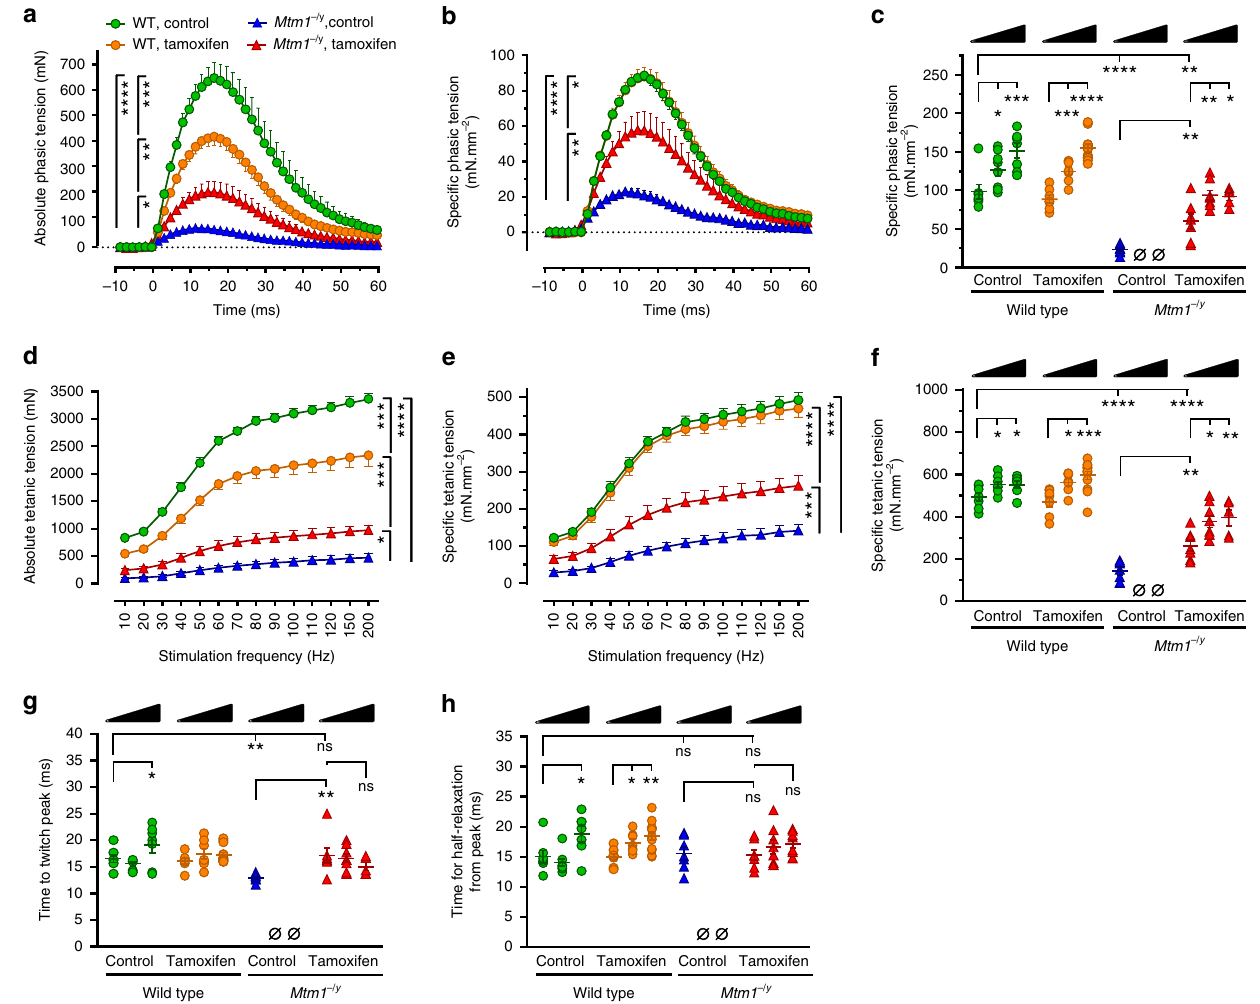
Fig. 2 Tamoxifen augments the strength of leg muscles of XLMTM mice. Electrically evoked triceps contractions were recorded under isometric conditions and contractile features analyzed in 42, 84, and 210-day-old mice fed placebo or tamoxifen-supplemented (30 mg kg − 1 ) diets. a Average traces showing absolute phasic (twitch) contraction of the triceps at 42 days (D42). Tamoxifen signi fi cantly enhanced the force (tension) in Mtm1 − /y mice. b Speci fi c phasic force (see Online Methods for details) of D42 Mtm1 − /y mice augmented with tamoxifen. c Speci fi c phasic force of Mtm1 − /y mice increased with tamoxifen at all examined ages. d Average traces showing triceps absolute force-frequency curves at D42. Tamoxifen more than doubled the tetanic force of Mtm1 − /y mice. e Speci fi c force of Mtm1 − /y mice markedly augmented with tamoxifen at all stimulation frequencies. f Speci fi c tetanic force of Mtm1 − /y mice was considerably improved at all studied ages. In triceps examined after various treatment durations, tamoxifen rescued the impaired time to twitch peak of Mtm1 − /y mice ( g ) but had no impact on the time required for half-relaxation from peak ( h ). D42 panels: WT wild type; legend in a stands for a , b , d , e ; data represent the mean ± s.e.m. of n = 7 triceps per group. c , f , g , h : black triangles illustrate increasing age (42 – 84 and 210 days) within each treatment group; columns from left to right: data represent the mean ± s.e.m. of 7; 8; 7; 7; 7; 13; 7; 0; 0; 7; 8; 6 triceps, respectively. * P ≤ 0.05; ** P ≤ 0.01; *** P ≤ 0.001; **** P ≤ 0.0001; ns non-signi fi cant, Ø no surviving mice. One-way ANOVA followed by Fisher ’ s LSD